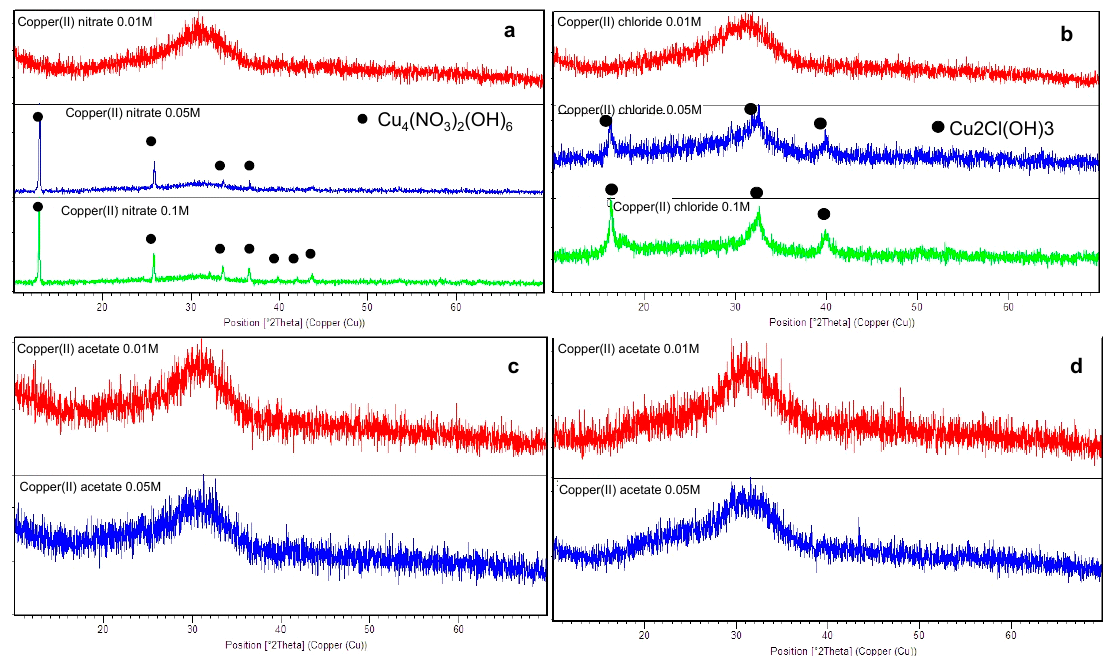
Figure 2. XRD analyses of SBA2 glass ion exchanged in ( a ) copper(II) nitrate; ( b ) copper(II) chloride; ( c ) copper(II) acetate; and ( d ) copper(II) sulphate solutions.